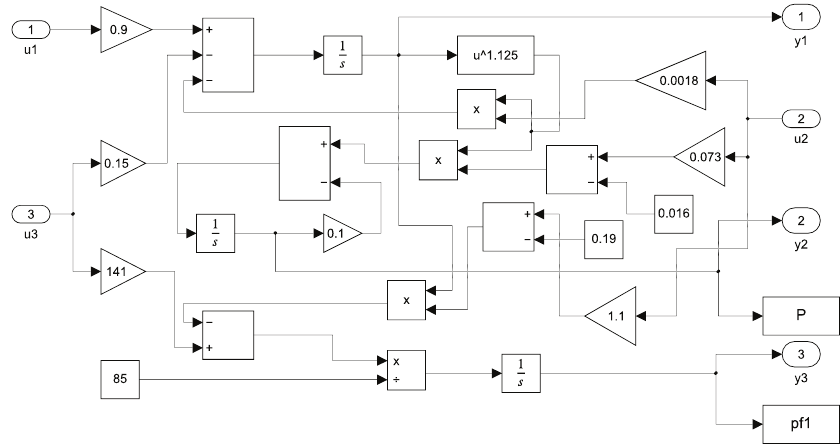
Figure 3. The block diagram of state equation in model (1) using